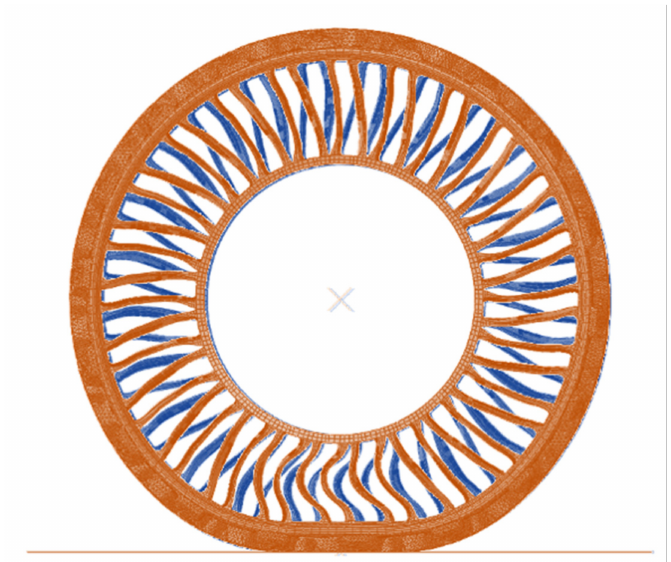
Figure 17. Deformed blue shape: braking condition. Deformed orange shape: driving